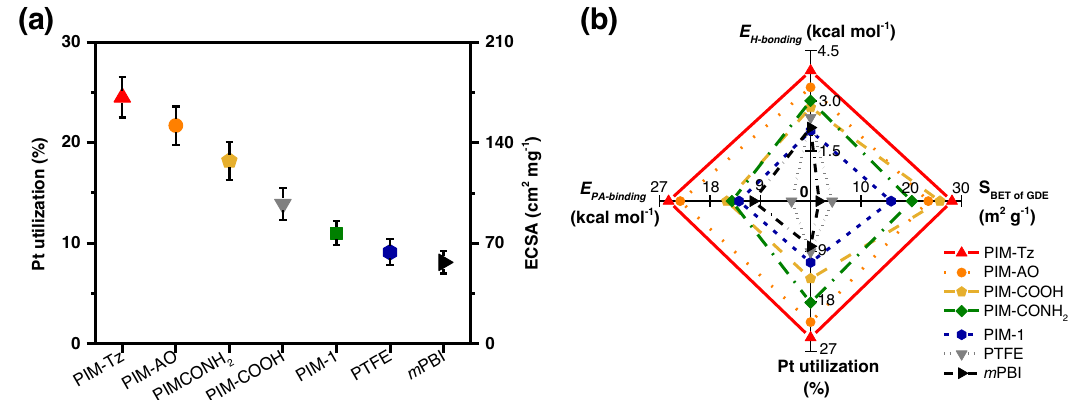
Fig. 4 | Electrochemical surface area estimation of the MEAs using PIMs as binders in the catalyst layer. a Pt utilization and ECSA of MEAs with different bindermaterials. b CorrelationofPtutilizationwiththehydrogen-bondingenergy, PA binding energy and S BET of porous GDEs with different binders. The error bars